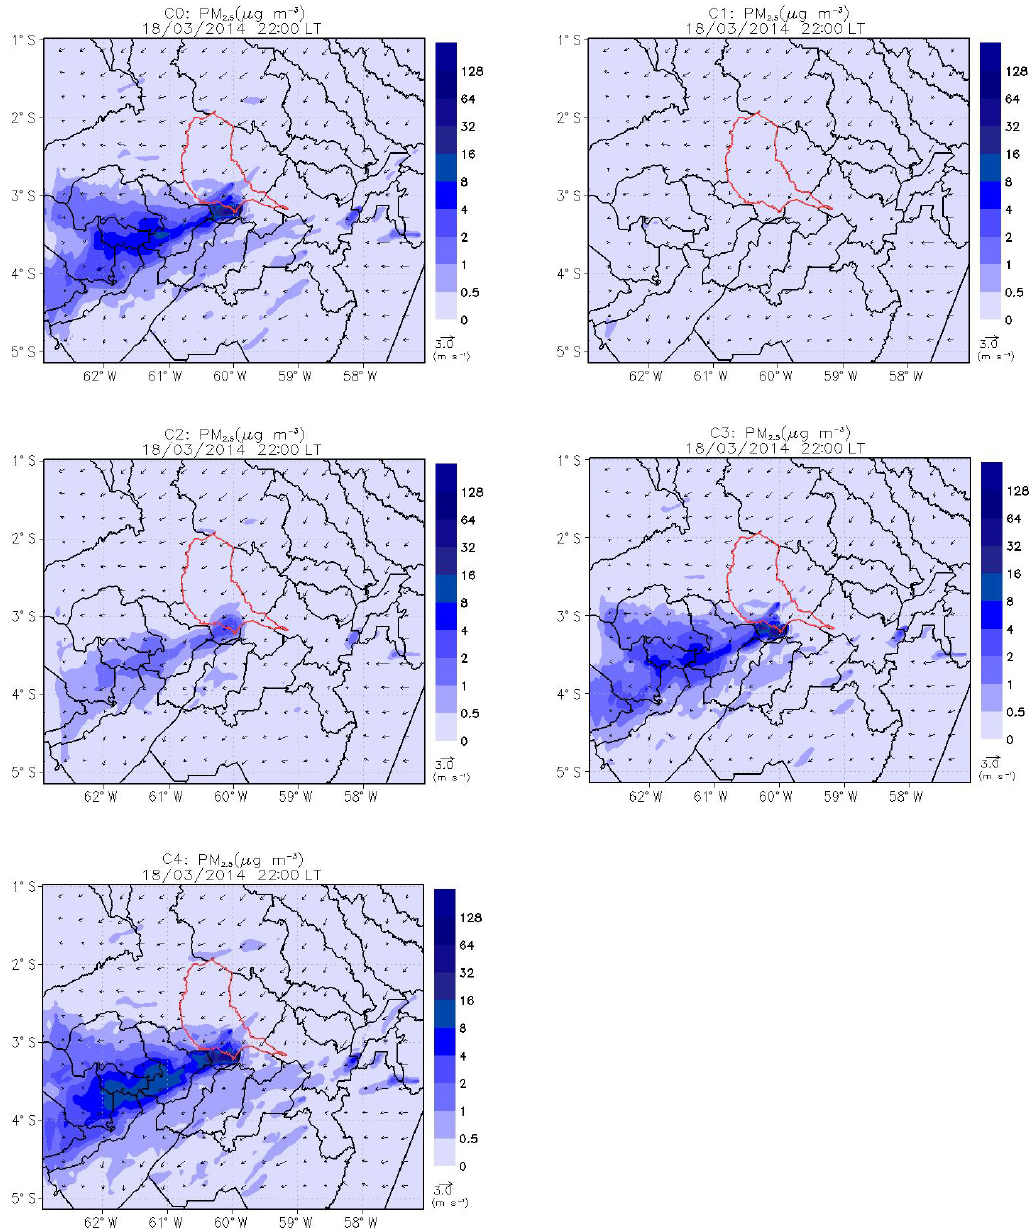
Figure 6. Spatial distribution of the scenarios studied for PM 2 . 5 concentration, calculated at 22:00, local time, on 18 March 2014. The black contours illustrate the delimitations of the municipalities on the grid, and the red one represents